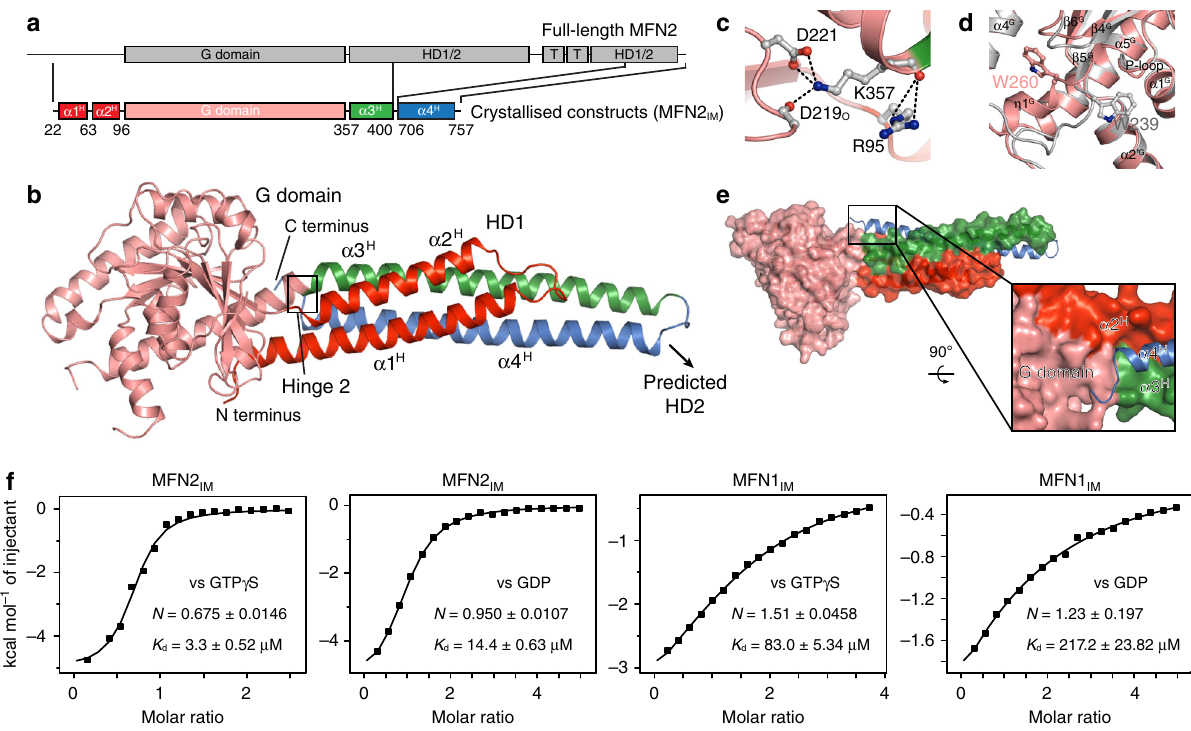
Fig. 1 Overall structure of truncated MFN2 IM a Schematic representation showing the organization of MFN2 IM based on full-length MFN2. G domain, GTPase domain; HD1/2, helical domain 1/2; T, transmembrane region. Elements for MFN2 IM are assigned according to the structure. Borders of each element are indicated by residue numbers. b Structure of nucleotide-free MFN2 IM . α -helices of HD1 are differentially colored to specify their distribution on the primary structure as in a . c Details of hinge 2 of MFN2 IM in nucleotide-free state. d Structural comparison between Trp260 in MFN2 IM (pink) and Trp239 in MFN1 IM (gray) in nucleotide-free states. e The C terminus of ɑ 4 H physically contacts the G domain. Nucleotide-free MFN2 IM is illustrated here. f Binding af fi nities (dissociation constant, K d ) to guanine nucleotides for nucleotide-free MFN2 IM and MFN1 IM measured by isothermal titration calorimetry